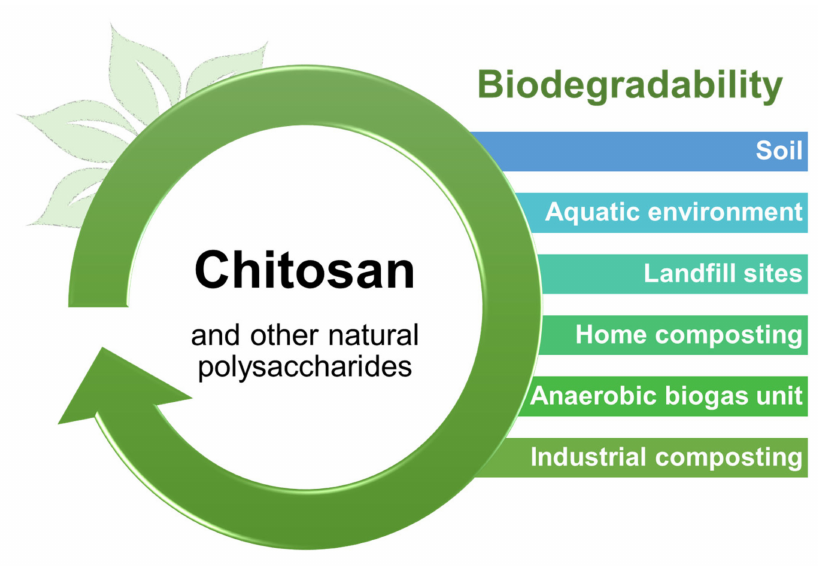
Figure 5. Biodegradability of chitosan and other natural polymers on various